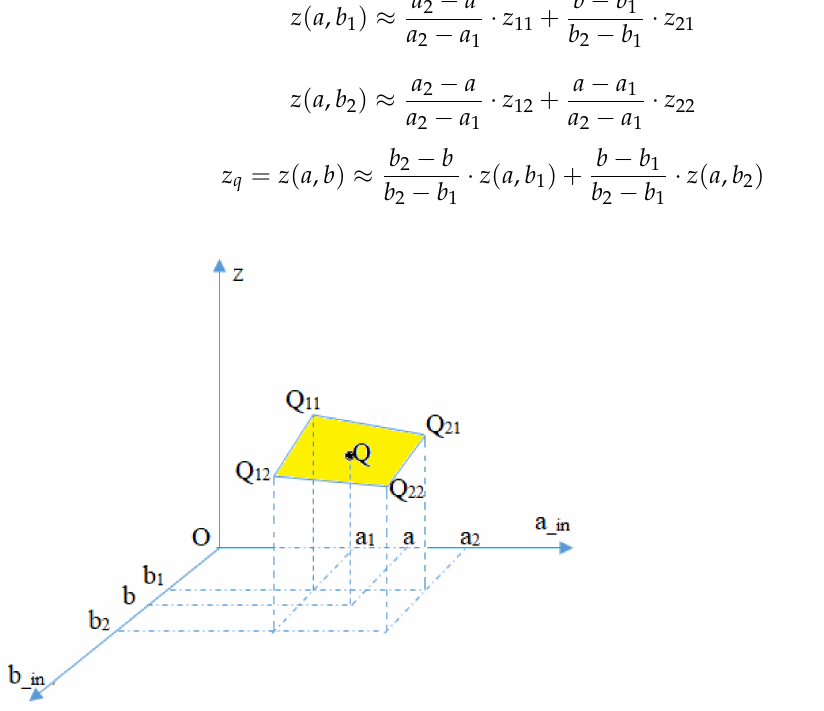
Figure 3. The four-point bilinear interpolation. Here, Q 11 = ( a 1 , b 1 , z 11 ), Q 12 = ( a 1 , b 2 , z 12 ), Q 21 = ( a 2 , b 1 , z 21 ), Q 22 = ( a 2 , b 2 , z 22 ), and Q = ( a , b , z q